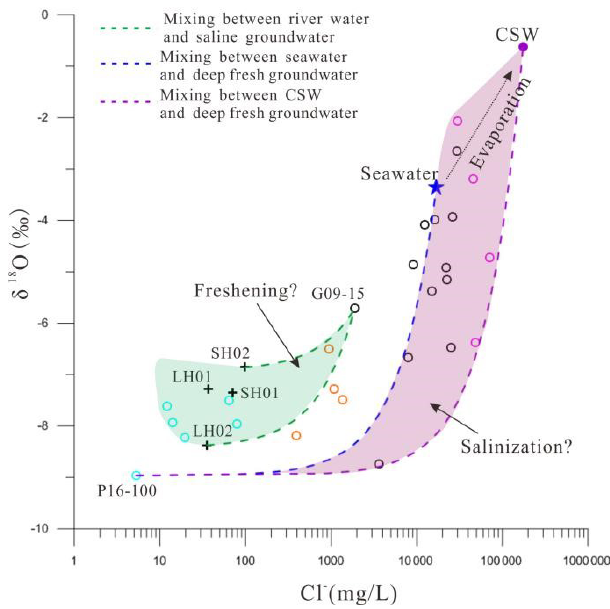
Figure 8. Plot showing the relationship between Cl − and δ 18 O in different water samples as a means to probe various mixing pro- cesses in the Luanhe River delta. The symbols are the same as used in Fig. 6. The green area is the assumed freshening zone, and the purple area is the assumed salinization